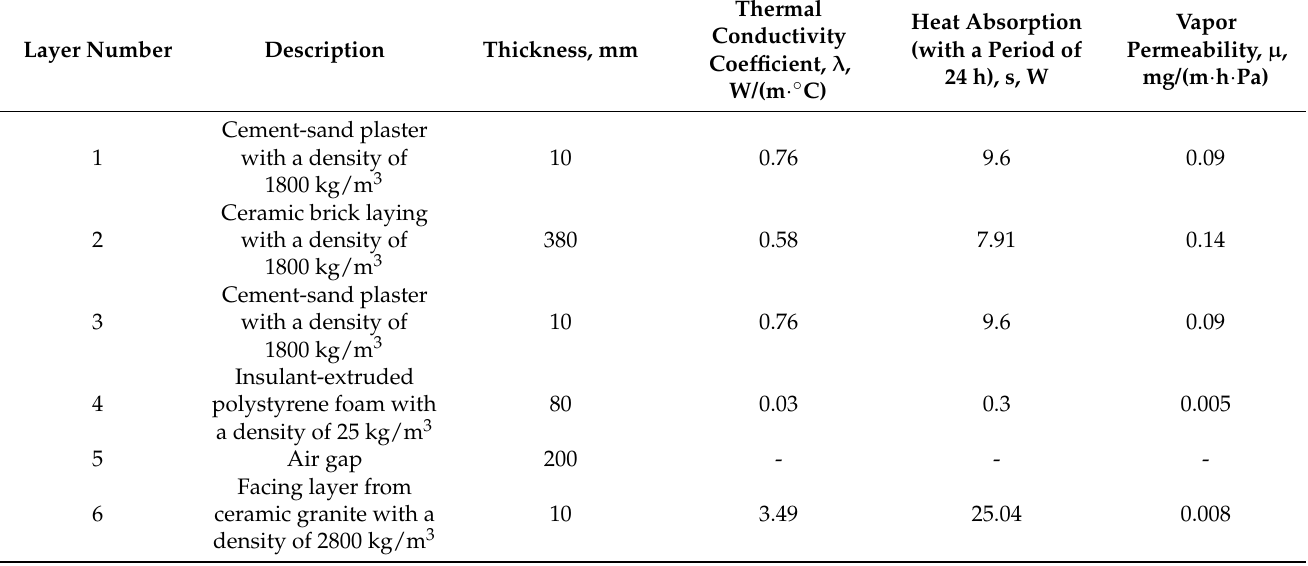
Table 1. Characteristics of the enclosing structure layers according to Figure 1 [36].